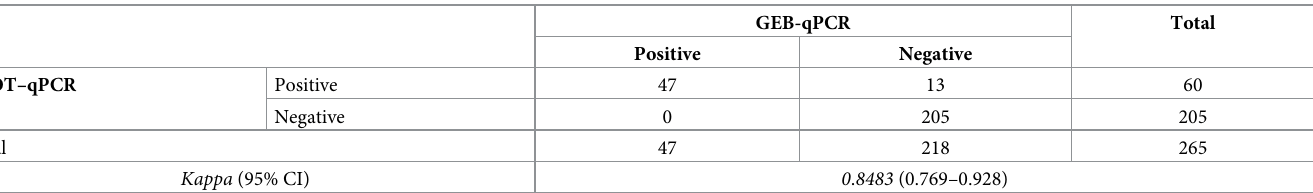
Table 3. Comparison of qPCR using DNA extracted from GEB or clot.